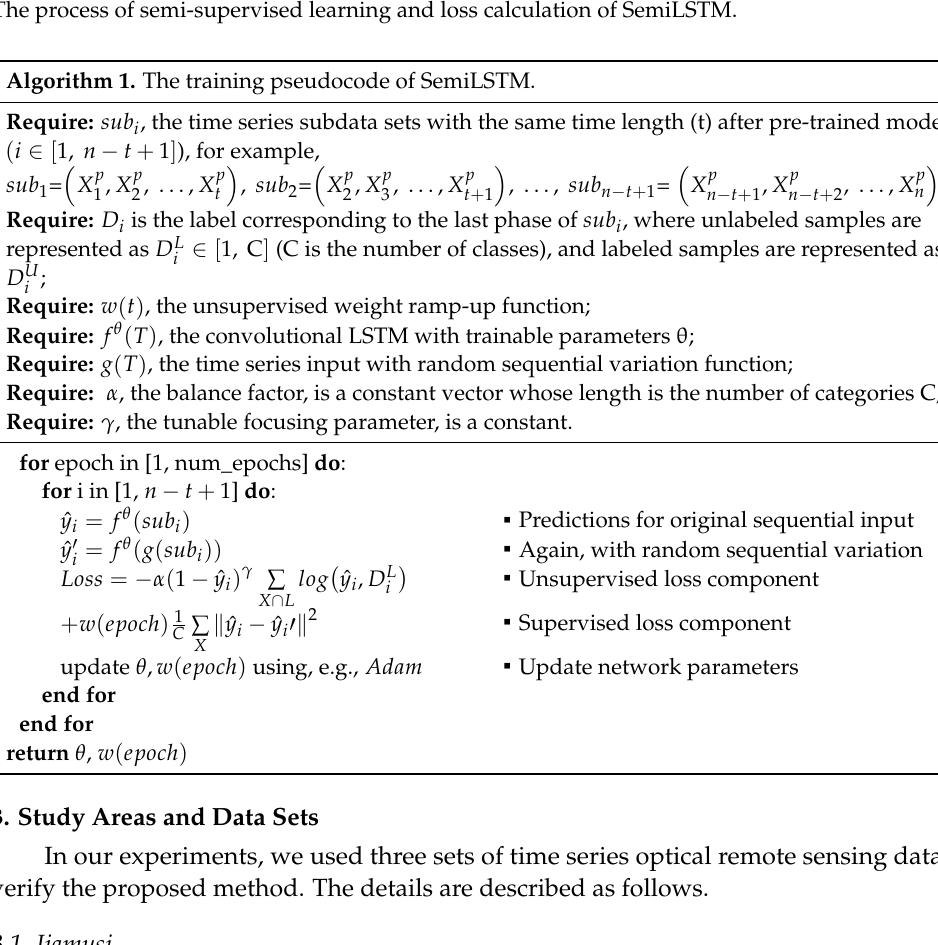
Figure 5. Study area locations of Jiamusi and Kunshan . We used three small areas ( J1 , J2 , and J3 ) with the size of 256 × 256 pixels in Jiamusi from 2015 to 2016. The Kunshan data spans from 1991 to 2010, and the image size is 1005 × 937 pixels. Besides, it covers six categories according to the actual situation, involving cultivated land, forest (including unused land), construction (incorporated buildings and roads), water, cloud, and shadow. Figure 6b illustrates the ground truth information of the last images ( J1 / J2 / J3 ). The distribution of the categories is imbalanced due to human activities. The proportion of each category is 65.20%, 9.38%, 22.29%, and 3.13% respectively. Clouds and shadows are easy to appear in summer, usually from June to August, and their coverage varies. In the past two years, forests and water have basically remained